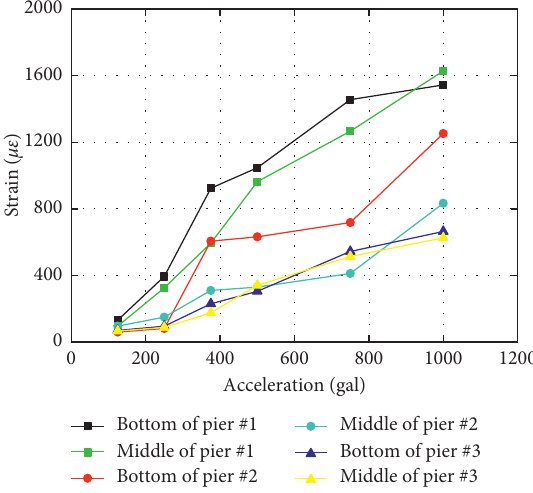
Figure 8: The strain response of bridge